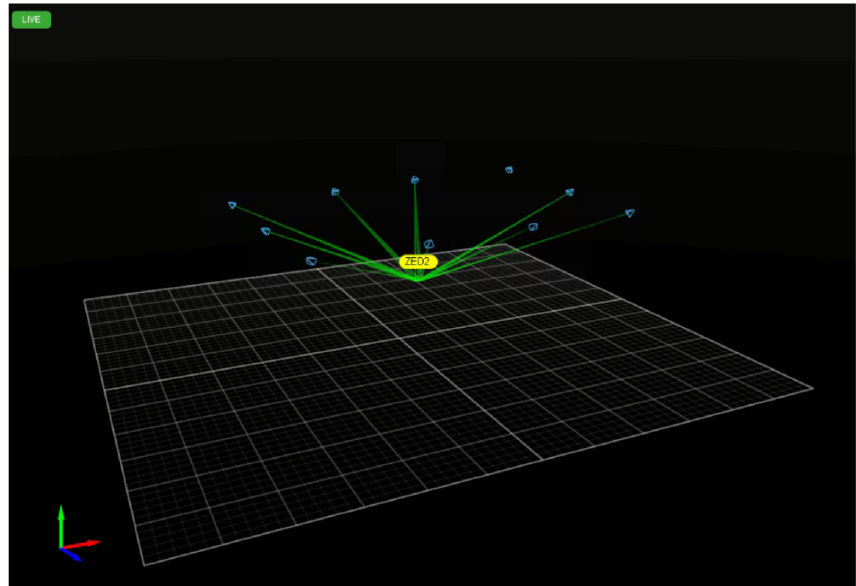
Figure 2. Tracking the movements of the ZED 2 stereo camera with the MIMO